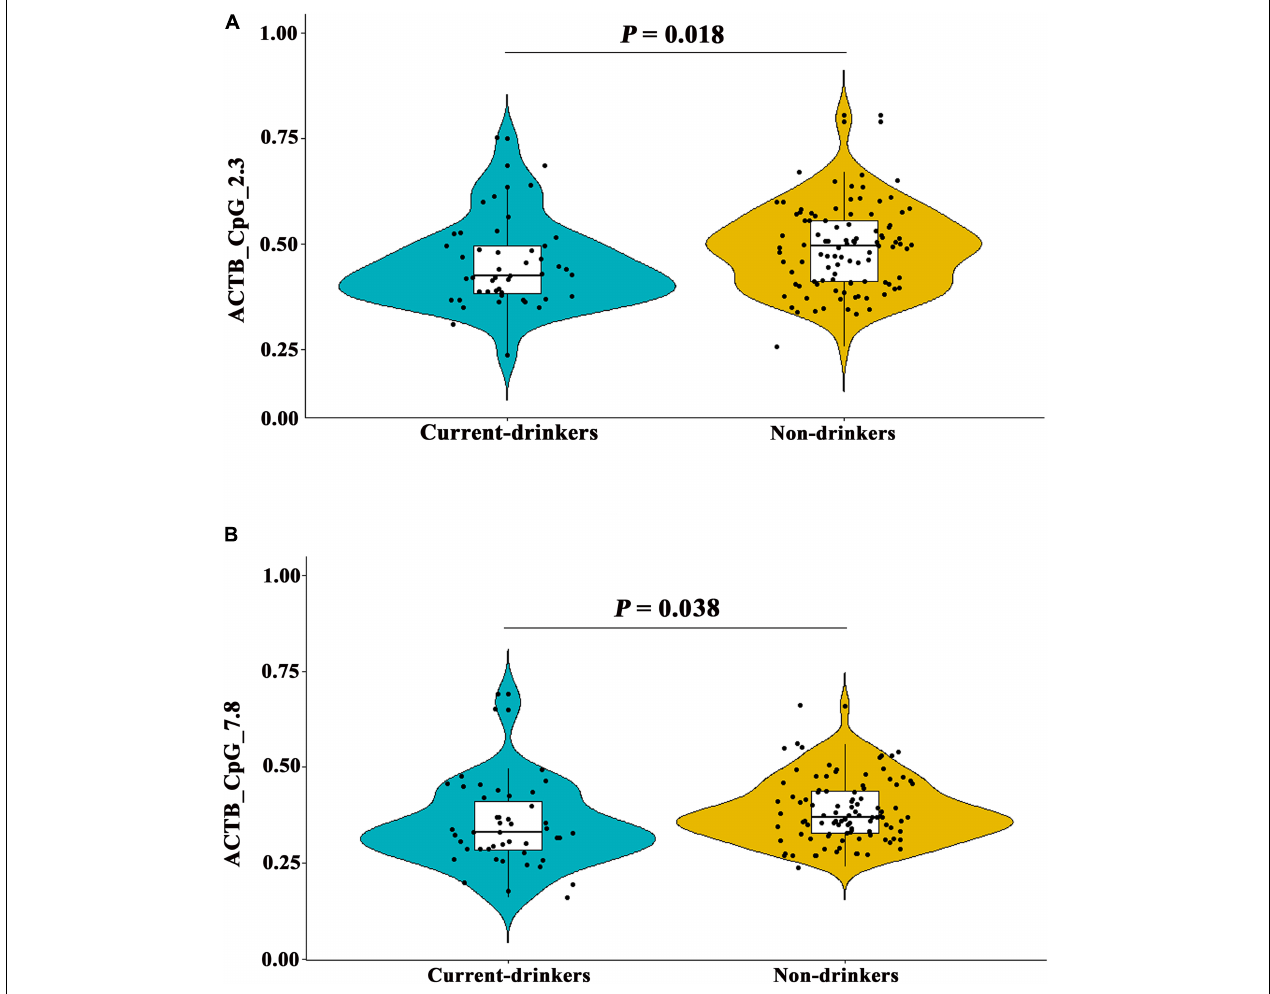
FIGURE 5 | Distribution of ACTB_CpG_2.3 and ACTB_CpG_7.8 methylation between current-drinkers and non-drinkers. The box plots show the distribution of CpG_2.3 and CpG_7.8 methylation levels in current-drinkers and non-drinkers. The black dots represent the individual data of CpG_2.3 and CpG_7.8 methylation levels. The P -values were calculated by logistic regression adjusting for age and sex. (A) Difference of ACTB_CpG_2.3 methylation levels between current-drinkers and non-drinkers. (B) Difference of ACTB_CpG_7.8 methylation levels between current-drinkers and